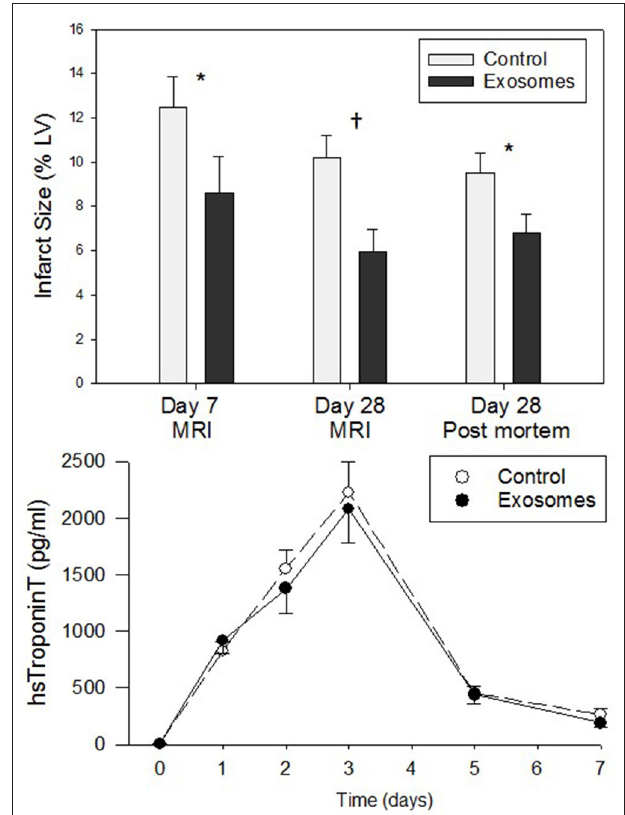
FIGURE 2 | (Top) Infarct size measured by cardiac magnetic resonance imaging (MRI) or post mortem left ventricle (LV) ring planimetry in ten pigs receiving 7 days intravenous administration of exosomes following myocardial infarction (MI) by means of left circumflex coronary artery ligation and ten pigs vehicle control treated MI pigs. (Lower) High sensitivity (hs) TroponinT plasma levels for 7 days post-MI in exosome (•) vs. control ( ◦ ) treated pigs. Values shown are mean ± SEM. Significant differences at time-matched points between the exosomes and control pigs are indicated as follows: * p < 0.05 and † p <